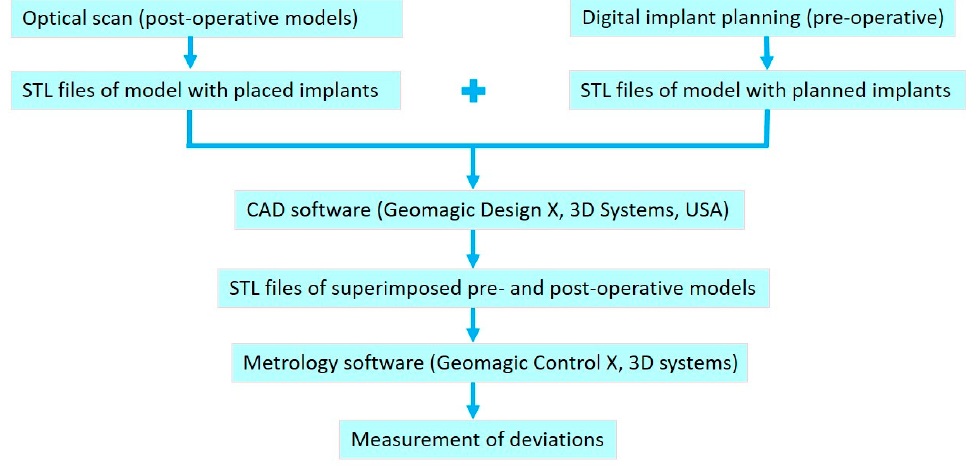
Figure 6. Summarized workflow of the accuracy assessment.